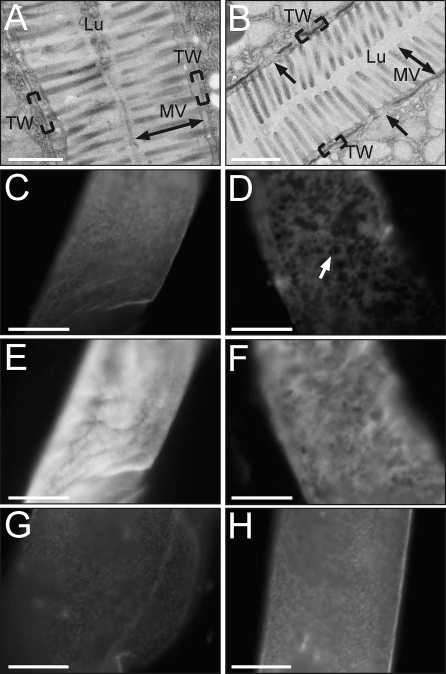
Infected Animals Have Lesions in the Terminal Web(A) Electron micrograph showing cross-section of intestine in uninfected animal.(B) Micrograph showing cross-section of intestine in N. parisii infected animal. Gaps in terminal web are indicated with arrows. (A, B) Brackets indicate terminal web (TW), double arrow indicates microvilli (MV), Lu indicates lumen, scale bar is 1 μm.(C) Uninfected intestine stained with MH33 antibody, which labels IFB-2, an intermediate filament component in the terminal web. Terminal web staining appears as a sheet, since image is from nonconfocal microscope.(D) Infected intestine stained with MH33. Gaps in MH33 staining are indicated with an arrow.(E) Same uninfected intestine as in (C), but visualizing ERM-1::GFP.(F) Same infected intestine as in (D), but visualizing ERM-1::GFP.Animal stained with MH33 antibody after being infected with P. aeruginosa strain PA14 for 27 h (G) or S. aureus strain NCTC 8325 for 24 h (H). Note gut distension due to PA14 infection. Scale bar is 10 μm (C–H).